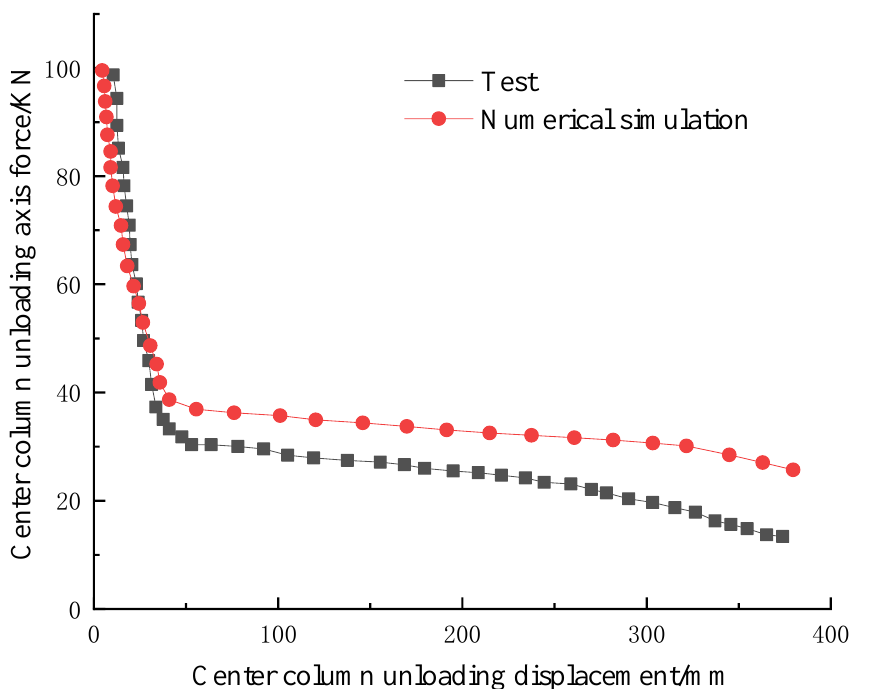
Figure 1. Shows the relationship between axial force and unloading displacement .